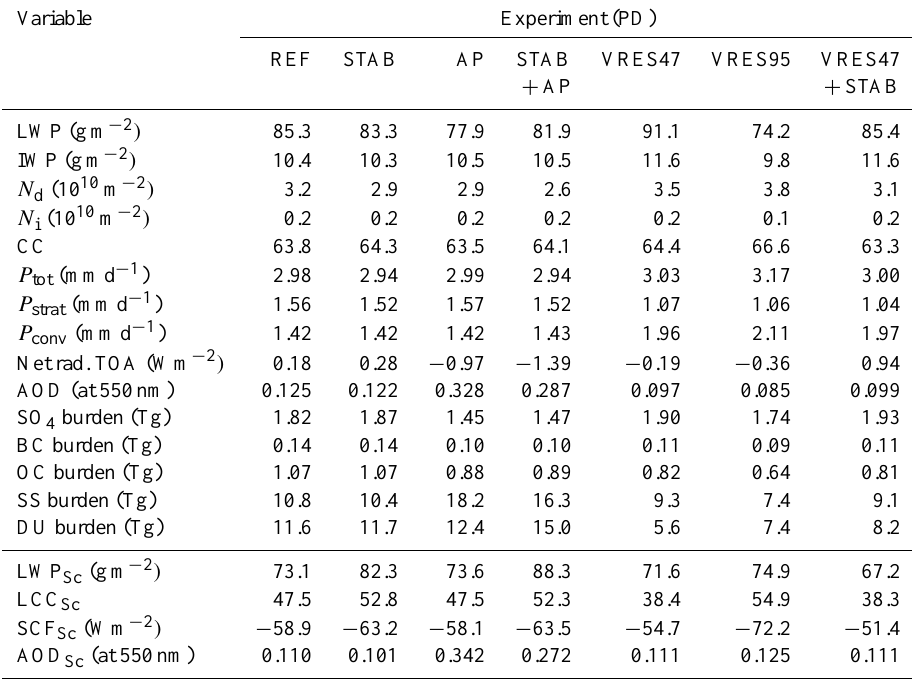
Table 2. Aerosol, cloud and forcing parameters for present-day CLIM simulations for all experiments. Global values and values in the stratocumulus regime are given. Note that the results with L47bl and L95bl are from 1-year simulations. LWP is liquid water path, IWP is ice water path, N d and N i refer to the vertically integrated cloud droplet and ice crystal number concentration, (L)CC is (low) cloud cover, P tot / P strat / P conv are total/stratiform/convective precipitation, SCF is shortwave cloud forcing and AOD is the aerosol optical depth. Global annual mean burdens for sulfate (SO 4 ) , black carbon (BC), organic carbon (OC), sea salt (SS) and mineral dust (DU) are also shown. The subscript Sc represents values in the stratocumulus regime.